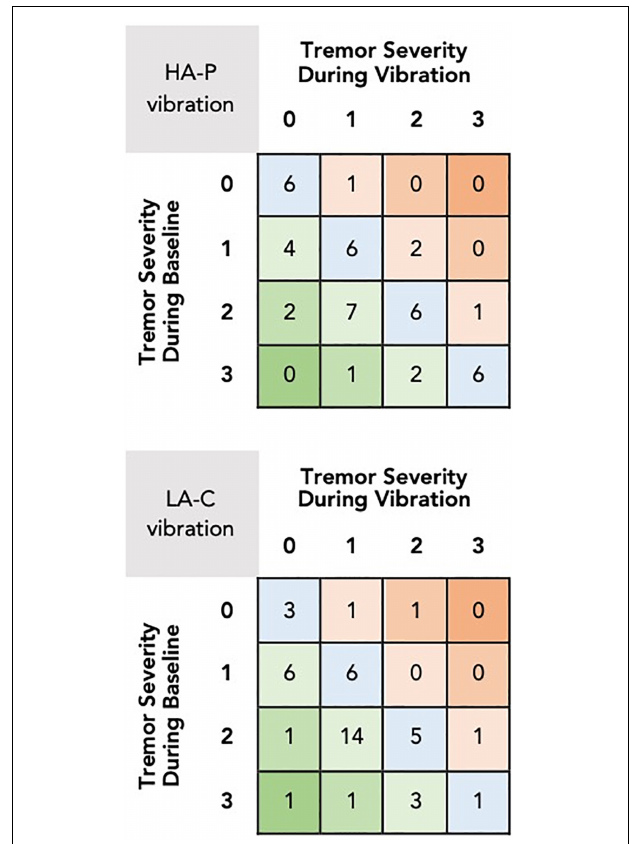
FIGURE 3 | Changes in median resting tremor severity scores between baseline and during vibration for the HA-P (top) and the LA-C (bottom) vibration trials. The rows and columns of the grid refer to the tremor severity scores during baseline and vibration, respectively, with each square displaying the number of subjects who received these scores. Squares in the lower left corner of the grid represent the number of subjects that exhibited reductions in tremor severity with the vibrotactile stimulation, squares in the upper right represent increases in tremor severity, and squares in the main diagonal represent no